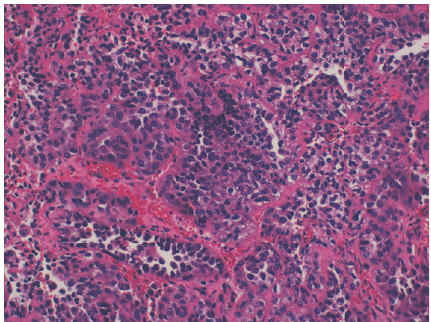
Figure 6: Pathological findings of the right ovary: clear cell carcinomaof therightovary(H-E × 20) and proliferation infiltration of hobnail-like cells with pale eosinophilic